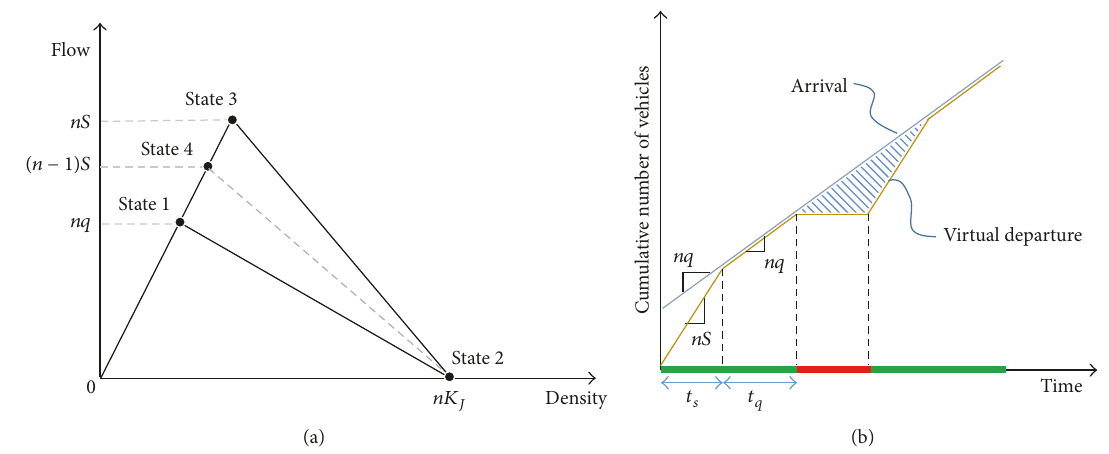
Figure 2: (a) Triangular fundamental diagram for the street with a number of 𝑛 lanes. (b) Illustrative queuing diagram for undersaturated